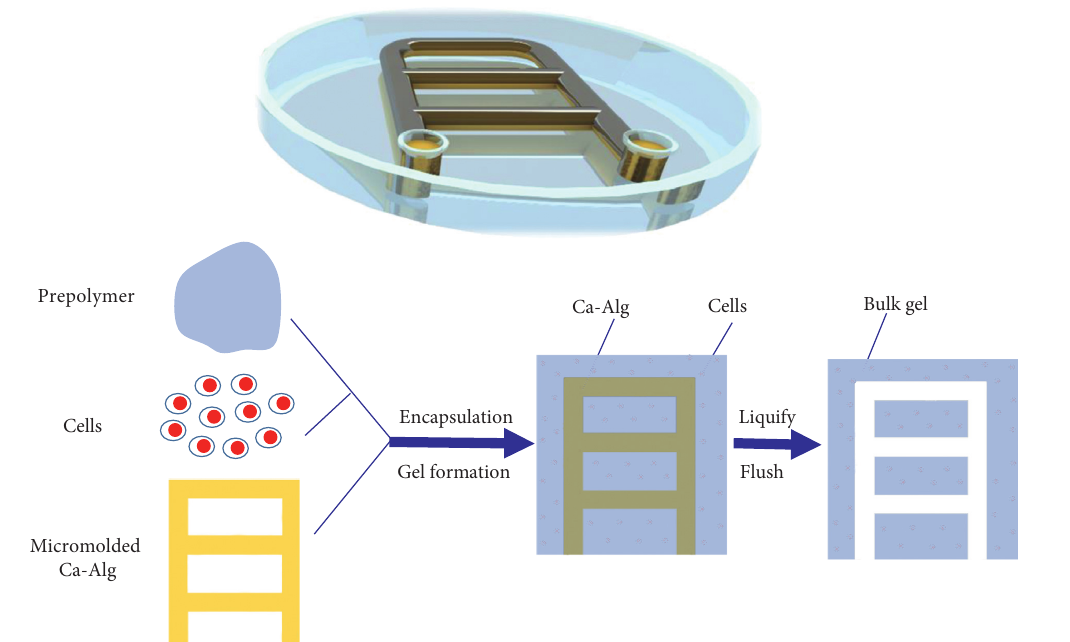
Figure 1: Schematic of the microfluidic network fabricated by sacrificing the micromolded Ca-Alg. The process includes fabricating a micromolded Ca-Alg, encapsulating this model in a second gel, and removing it by ion-exchange to leave microchannels in the remaining gel.